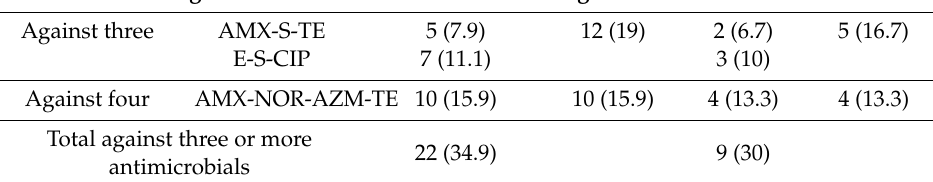
Against two AMX-TE AMX-S Against Three or More Antimicrobial Agents Against three AMX-S-TE Against four Total against three or more